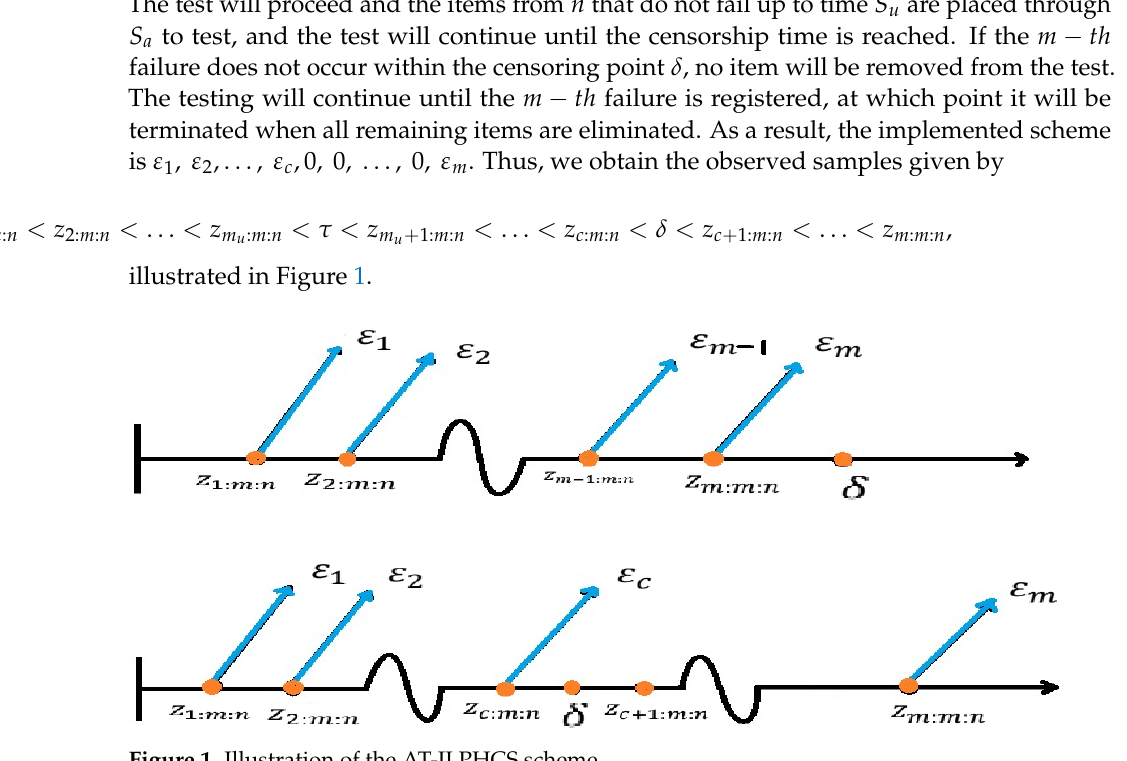
Figure 1. Illustration of the AT-II PHCS scheme.